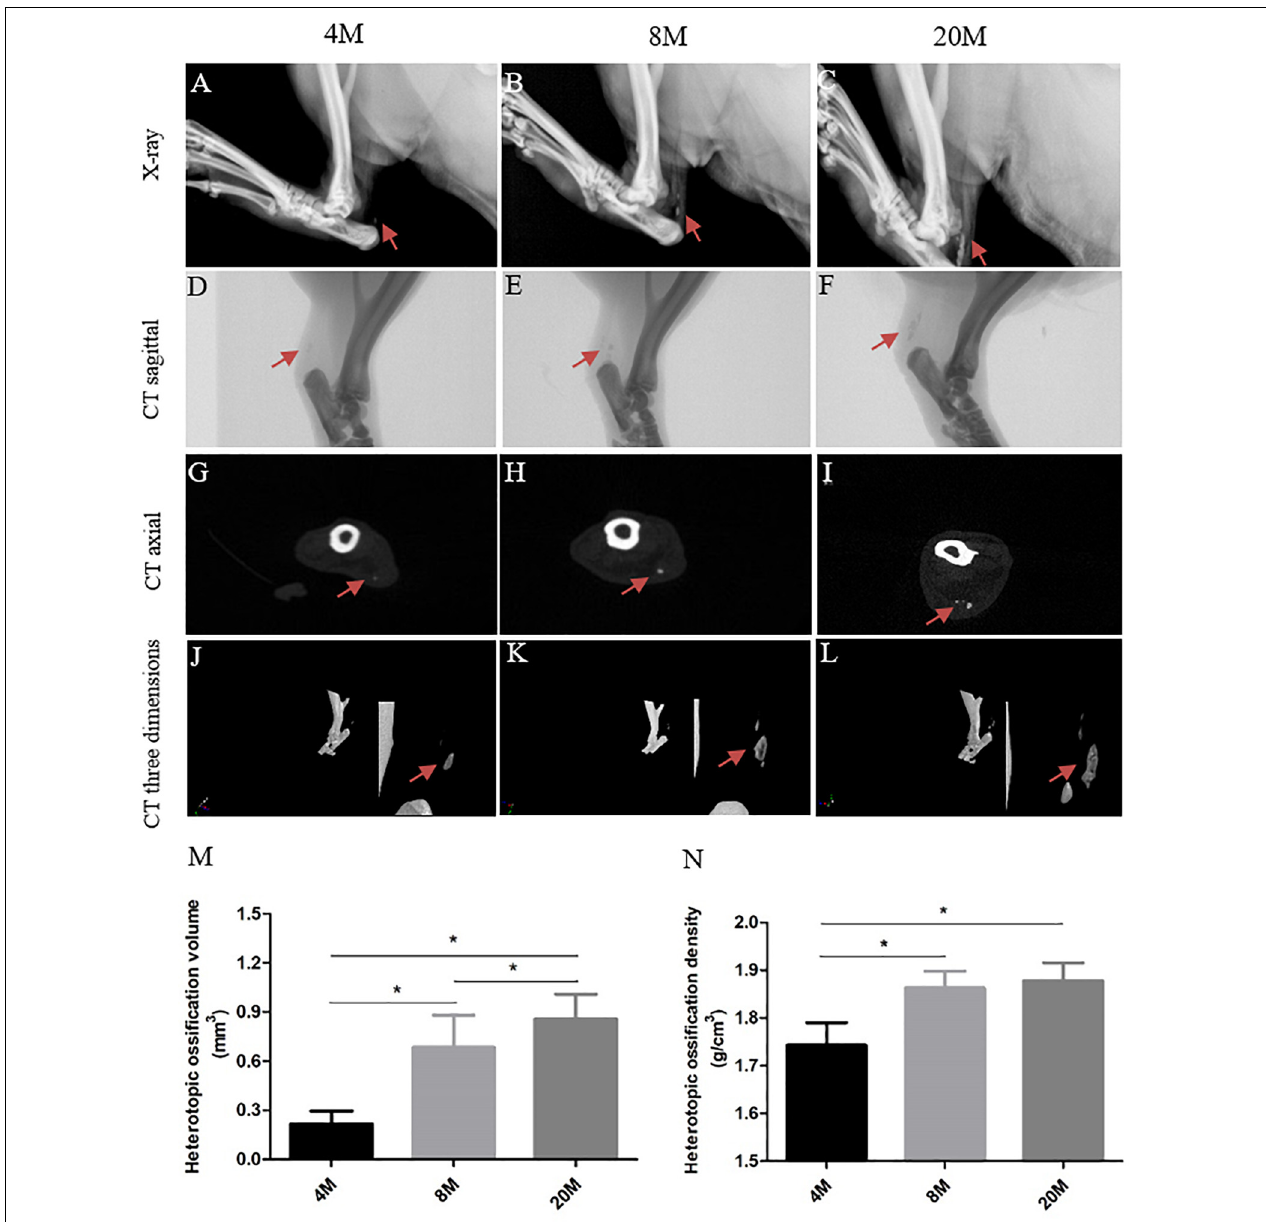
FIGURE 1 | Imaging evaluation of heterotopic ossification. Imaging evaluation of heterotopic ossification in rat Achilles tendon aged 4, 8, and 20 M. (A–C) Representative X-ray figures from rats aged 4, 8, and 20 M. The visible radiopaque area presents the heterotopic ossification formation in tendon, and red arrows show the ossification region. Representative CT sagittal view (D–F) , CT axial view (G–I) , and CT three-dimensional view (J–L) figures from rats aged 4, 8, and 20M. Statistical diagrams show the increased trend with age in the volume (M) and density (N) of heterotopic ossification. ∗ P < 0.05.